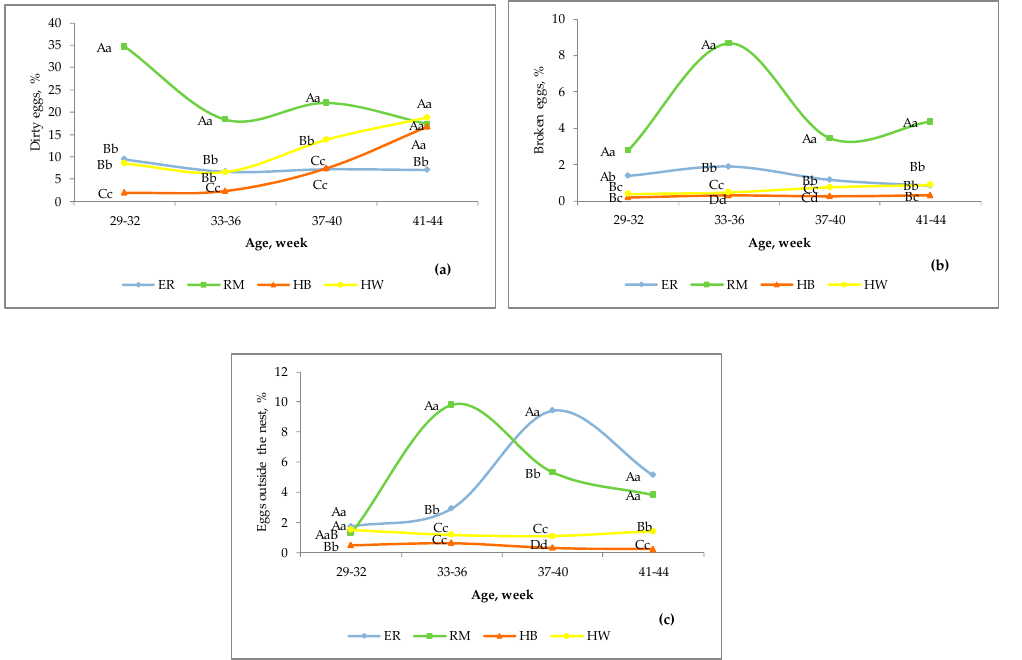
Figure 3. E ff ect of genotype 1 on dirty eggs ( a ), broken eggs ( b ) and eggs outside the nest ( c ) according Figure 3. Effect of genotype 1 on dirty eggs (a), broken eggs (b) and eggs outside the nest (c) to the age of the hens. Di ff erent letters among lines at each age indicate di ff erent values. a, b, according to the age of the hens. Different letters among lines at each age indicate different values.